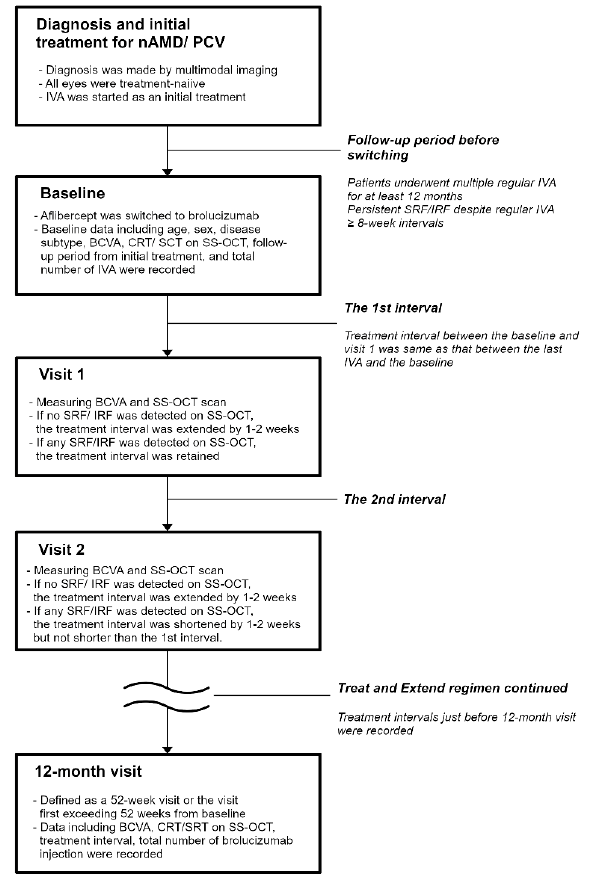
Figure 7. The flow-chart of treat-and-extend regimen. AMD, age-related macular degeneration; BCVA, best-corrected visual acuity; CRT, central retinal thickness; IRF, intraretinal fluid; IVA, intravitreal injection of aflibercept; SCT, subfoveal choroidal thickness; SRF, subretinal fluid; SS-OCT, swept-source optical coherence tomography.